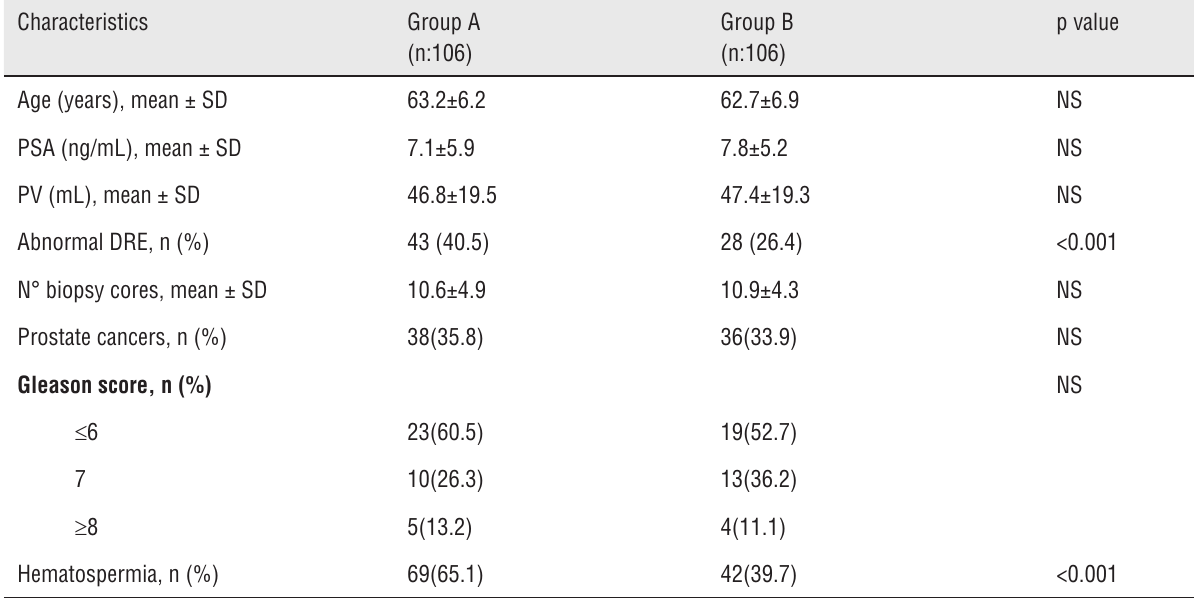
Table 1 - Demographic and clinicopathologic features of patients undergoing transrectal prostate biopsy.